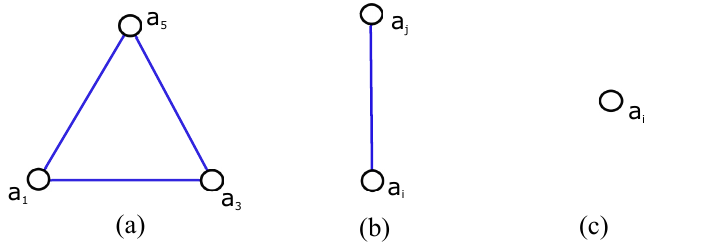
Figure 6. Three possible components of the graph G D if α 2 = α 4 = α 6 = 0. ( a ): α i > 0 for each i ∈ I o